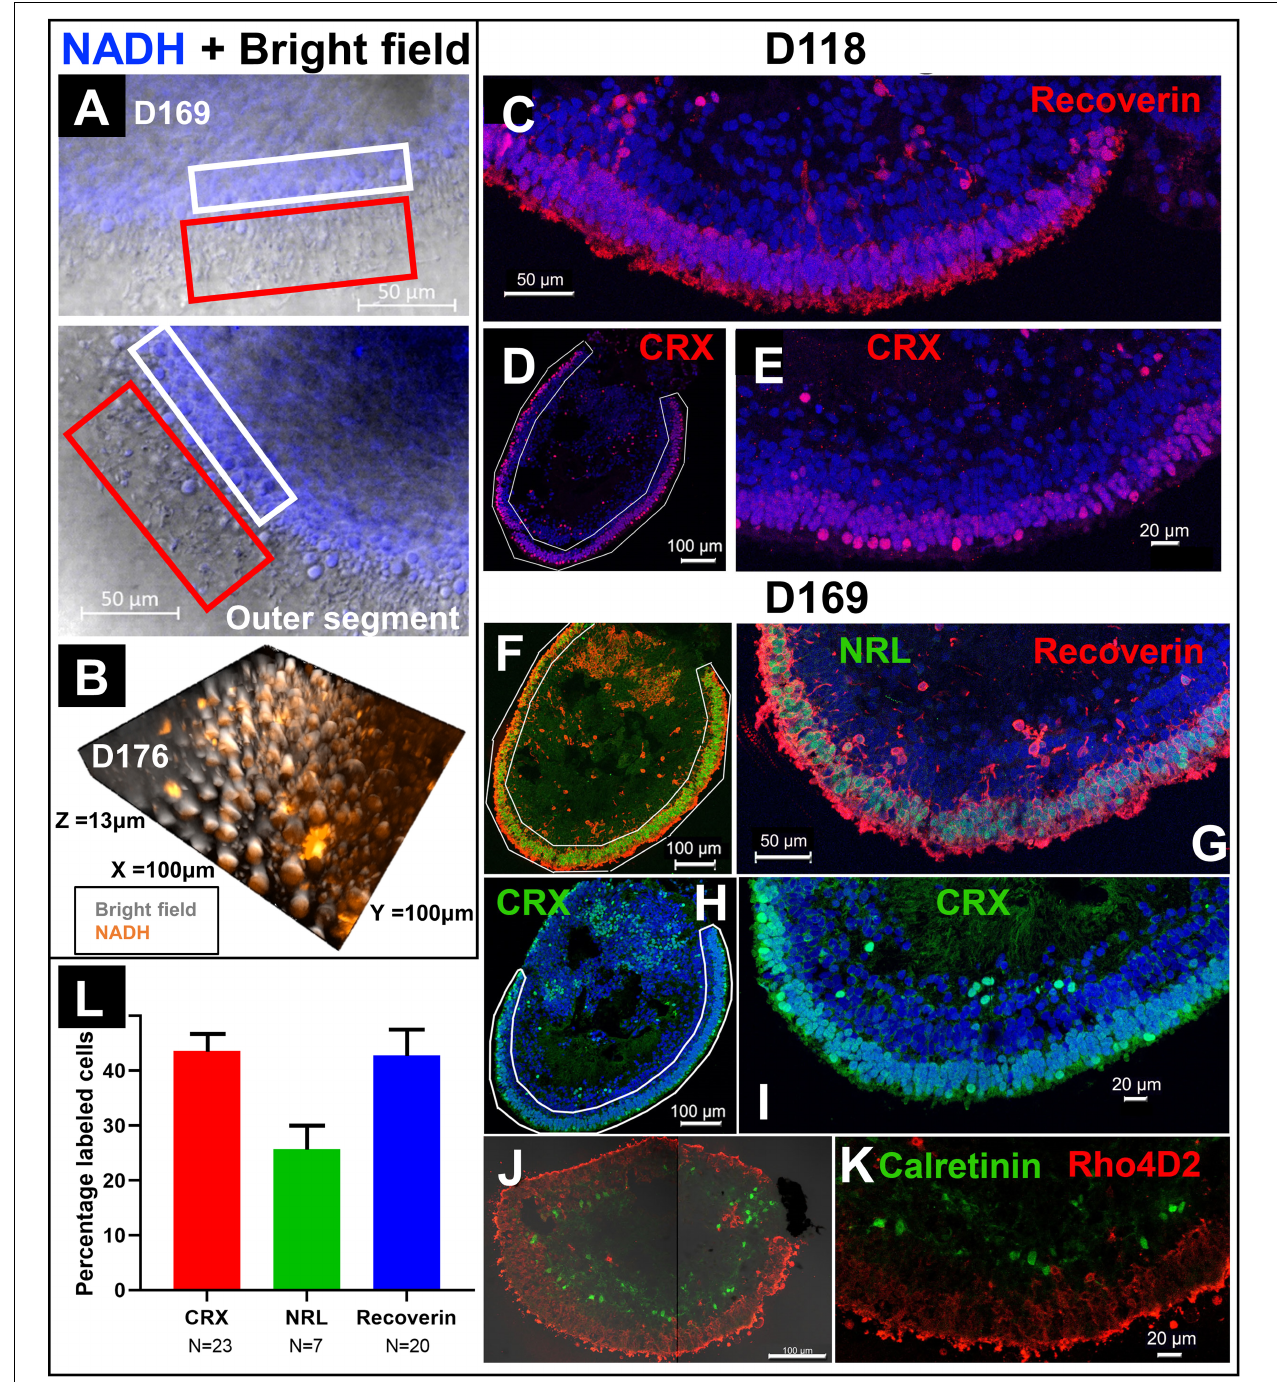
FIGURE 4 | Comparison of immunohistology and 2P autofluorescence imaging. (A) Live imaging of a RtOg on D169 of differentiation using 2P microscopy (combination of brightfield and NADH autofluorescence). The white box frames the outer nuclear layer (ONL) and the red box the outer segment-like structures. (B) 3-D reconstruction from Z-stack images of the surface of a RtOg on D176 with 2P microscopy (combination of brightfield and NADH autofluorescence). (C–E) Immunohistology images of a RtOg at D118. (F–K) Immunohistology images of a RtOg on D169. (L) Cell counting plot from selected immunohistology slides (Error bar is the standard error of the mean). Antibody-marked cells: Recoverin and CRX – photoreceptor cells; NRL – rod photoreceptor cells; Rho4D2 – rod photoreceptor cells; Calretinin – amacrine cells. Nucleus were stained with DAPI (blue).